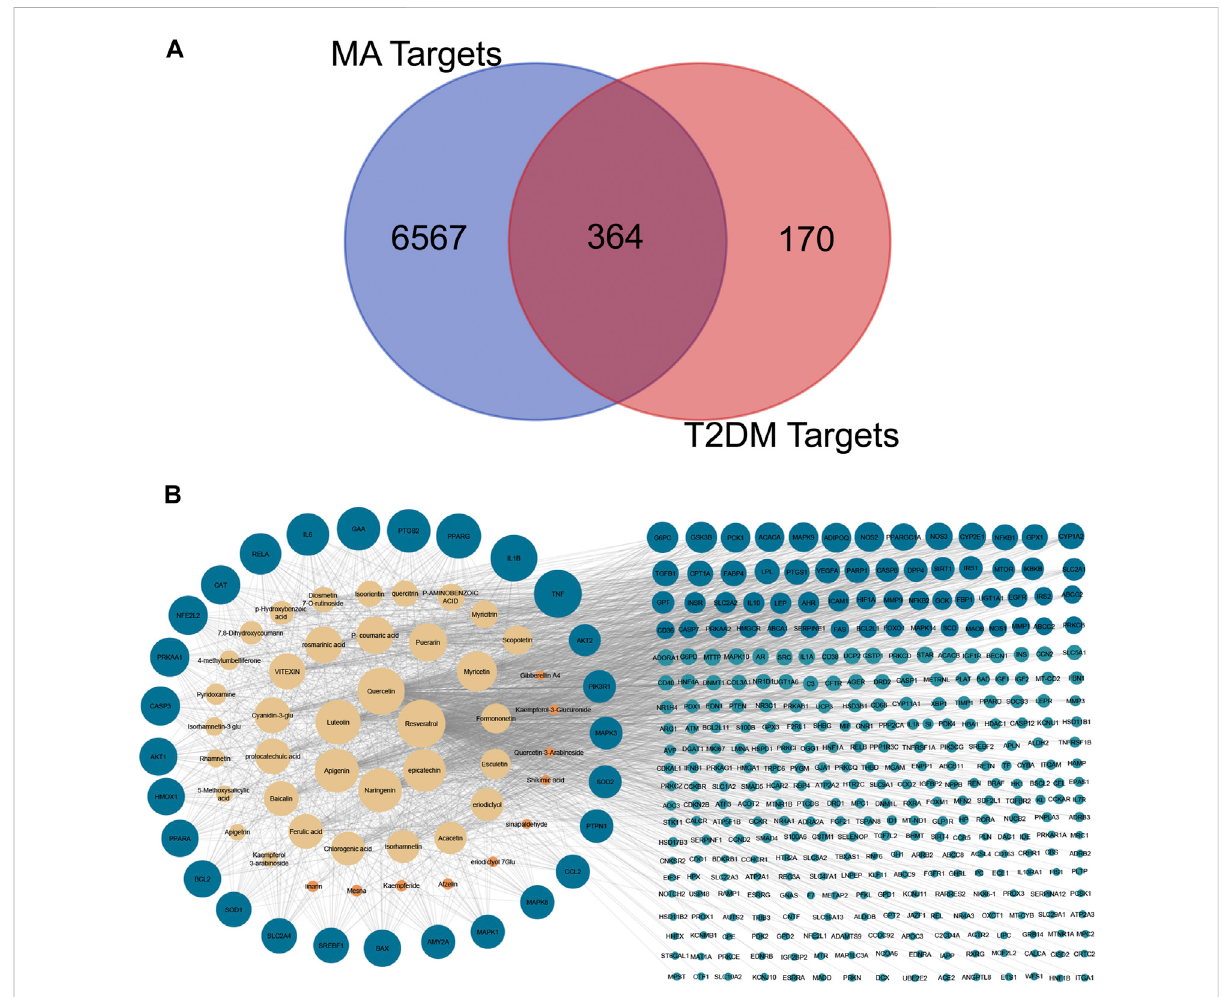
FIGURE 4 Venndiagramandcompounds-targetsinteractionnetwork. (A) VenndiagramShowstheintersectionbetweenMAtargetsandT2DMtargets (B) network shows the interaction between MA phytochemicals and T2DM targets. Yellow nodes represent compounds with degrees more than the network ’ s 2-fold median, while orange represent compounds with degrees are less than that. Blue nodes represent targets with more than the network ’ s2-foldmedian,whilegreennodesrepresenttargetswhosedegreesarelessthanthat.Adjustingthesizeoftheimagesandresolution, adding the panels ’ letters, and combining the images was carried out using